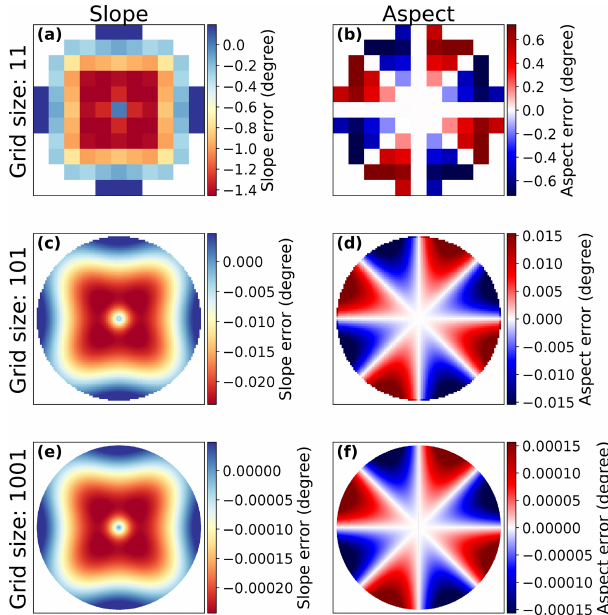
Figure 3. Gaussian hill slope (a, c, e) and aspect (b, d, f) errors from the analytical TE. All grid sizes show clear spatial patterns in slope and aspect errors. Offset magnitudes scale with grid size. Errors on the n = 1001 grid (e, f) are generally 2 orders of magnitude smaller than those for the n = 101 grid (c, d) . Colors are scaled from the 5th to 95th percentiles of error